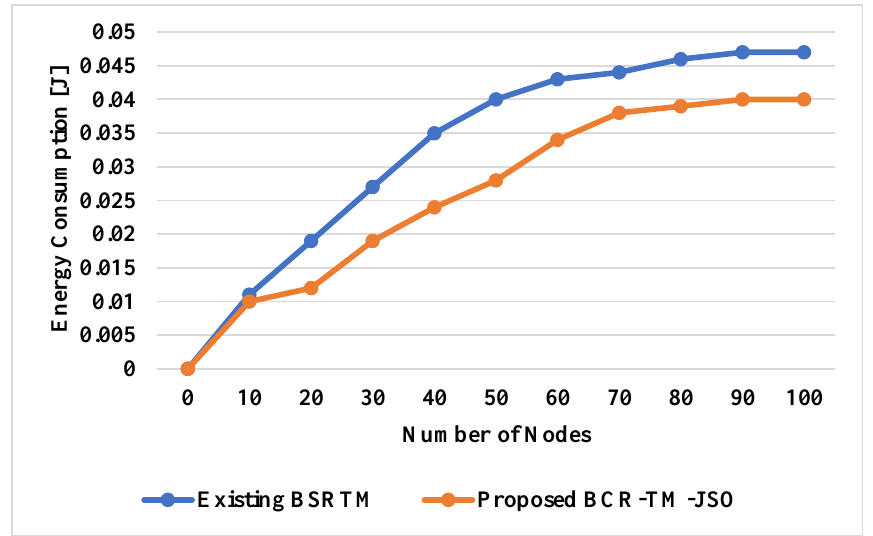
Figure 11. Performance of Energy Consumption with existing BSRTM [21].